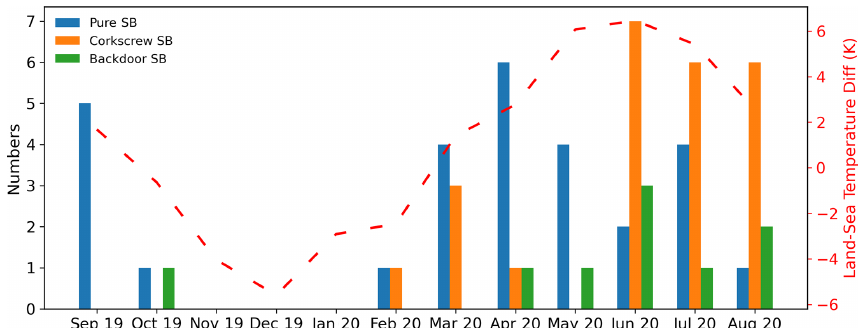
Figure 5. Monthly time series of identified sea breeze events from September 2019 (Sep 19) to August 2020 (Aug 20) showing pure sea breezes (blue), the corkscrew sea breezes (orange) and the backdoor sea breezes (green). The red dashed line indicates the monthly averaged land–sea temperature difference at